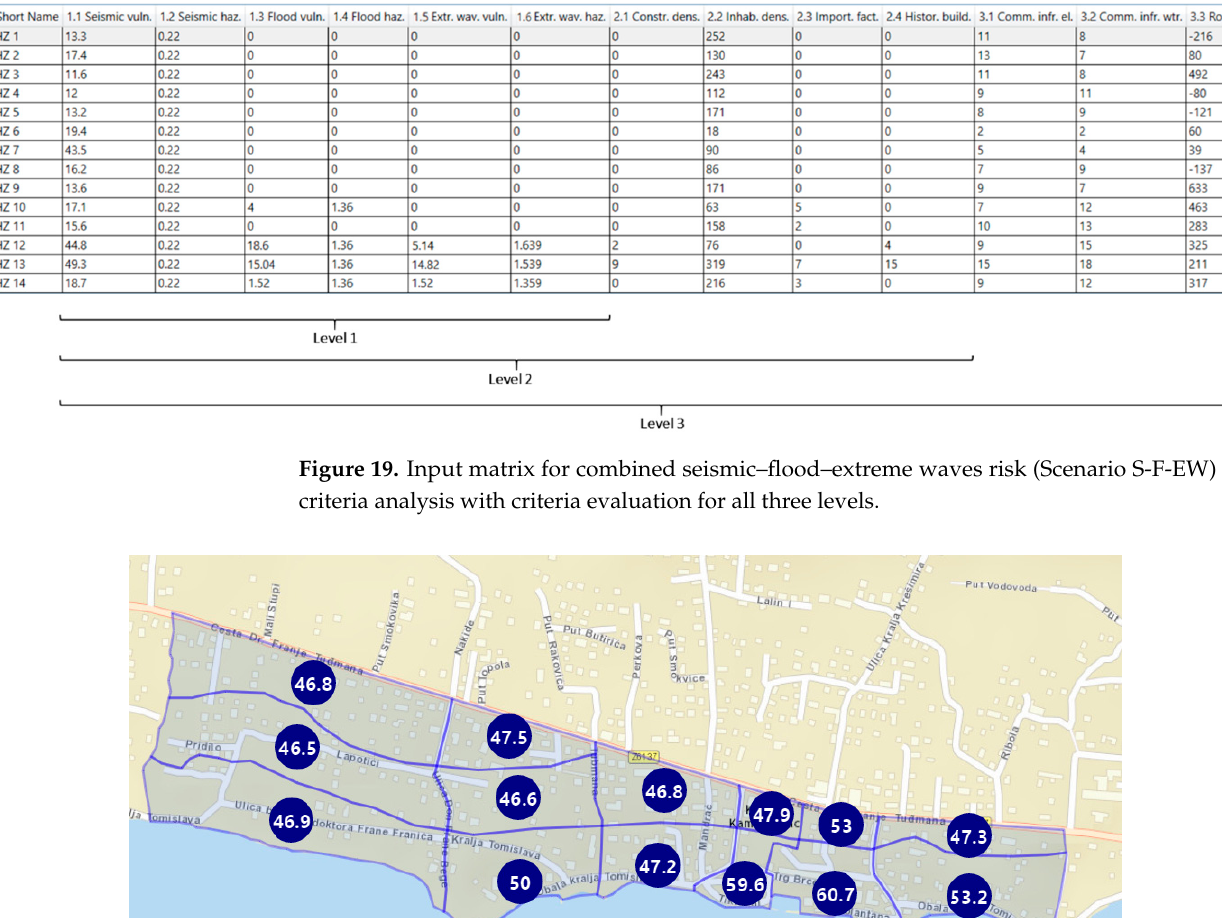
Figure 19. Input matrix for combined seismic–flood–extreme waves risk (Scenario S-F-EW) multi- criteria analysis with criteria evaluation for all three levels.